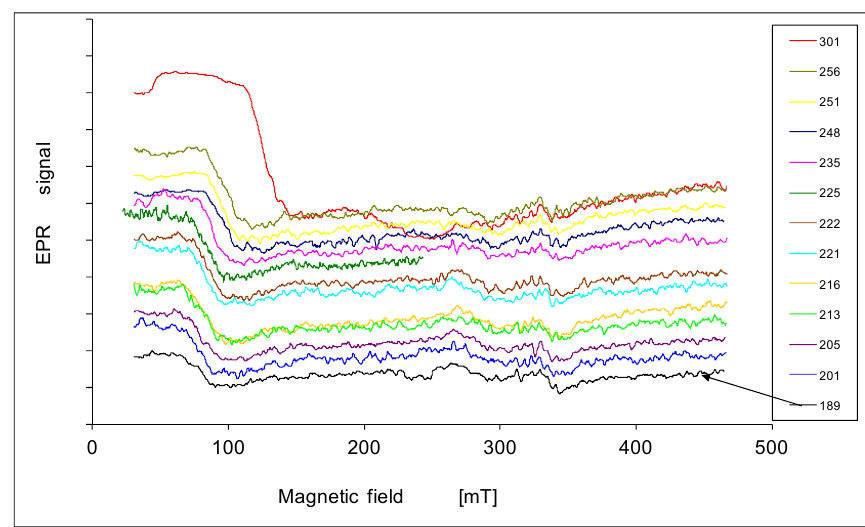
Figure 1. EPR spectra of the sample 1p at various temperatures in K.